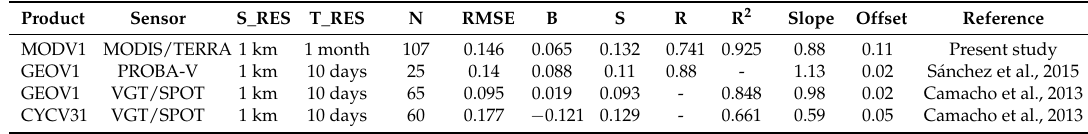
Figure 3. Direct validation results. ( a ) Comparison of FCover variable estimates with the corresponding FCover values from the CEOS BELMANIP2 and ImagineS datasets (FCover observed). Dotted lines represent the target accuracy range, and dashed lines represent the optimal target accuracy range. ( b ) Percentage of valid monthly composite pixels after MODV1 gap-filling and location of ground data. The grid represents the new tiling system adopted for WGS84 MODV1 projection. Table 1. Comparison of statistics generated from the direct FCover MODV1 product validation with those generated from the other global FCover products: S_RES (dataset spatial resolution), T_RES (dataset temporal resolution), N (Number of samples), RMSE (Root Mean Square Error), B (average of the difference between the estimated FCover and the ground data), S (standard deviation of the difference between the estimated FCover and the ground data), R (correlation coefficient), R 2 (coefficient of determination), Slope (regression line slope), and Offset (regression line offset).